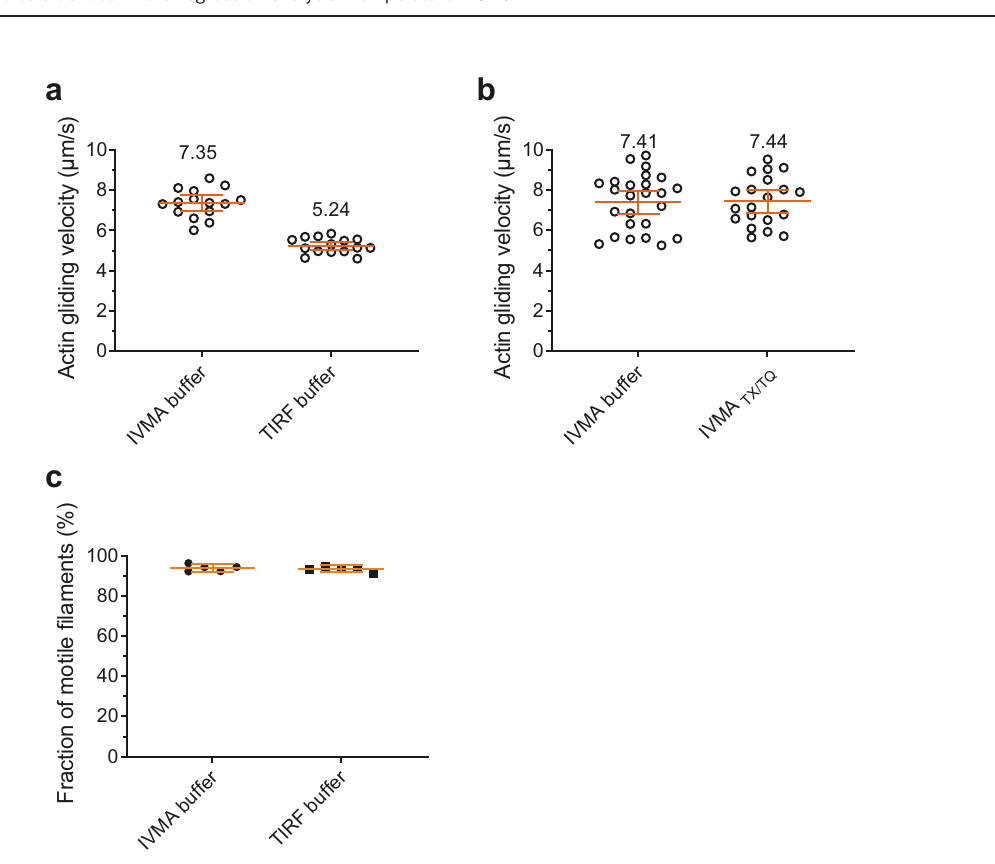
Fig. 2 Single molecule ATPase. a Two principles for surface immobilization of myosin motor fragments . b Time-averaged Alexa-ATP fl uorescence projections of 15 min videos (50 ms exposure time/frame). (i) Simple HMM deposition at 34.3 pM (left) and 343 pM (right). (ii) Optimized HMM deposition following high [ATP] wash. Only spots de fi ned by previous position of F-actin fi lament were included in analysis. (iii) Image of optimized actomyosin deposition followed by low [ATP] wash showing co-localization of Alexa-ATP fl uorescence (gray spots) and F-actin fi laments (yellow). Only spots co-localizing with F-actin fi laments were included in analysis. Bars, 5 µ m. c Representative time traces of (i) single-molecule Alexa-Ph bleaching, (ii) HMM basal ATPase, and iii, actin-activated HMM ATPase. Bleaching was observed either using standard in vitro motility assay (IVMA) buffer or optimized TIRF microscopy buffer (TIRFM) as described in the text (for details see Supplementary Information sections 1.2 and 1.9), whereas ATPase traces were from experiments using TIRFM buffer. d Cumulative frequency distributions of single-molecule Alexa-Ph until bleach or fi rst blinking event. The distributions are fi tted by single exponential functions (solid lines). e Cumulative frequency distribution of Alexa-nucleotide dwell time events on HMM surface hotspots (IVMA buffer — simple deposition of HMM, TIRFM buffer-optimized deposition of HMM) were fi tted with double-exponential functions (solid lines). IVMA data from 118HMM molecules, N dwell = 2112, TIRFM data from 45 HMM molecules, N dwell = 785. f Amplitudes and rate constants from the fi tting of data in e . Note appreciably lower rate constant values in TIRFM compared to IVMA buffer. g Cumulative frequency distributions of Alexa- nucleotide dwell time events comparing HMM basal (re-plotted from panel e ) and actin-activated ATPase activity. Actin-activated ATPase data were obtained from 37 actomyosin hotspots, N dwell = 879. The actin – myosin data were fi tted with triple exponential functions, whereas basal ATPase data were fi tted by double-exponential function as in f . h Rate constants obtained from fi ttings to data in f . i Amplitudes from fi tting the data in f . Error estimates refer to 95% con fi dence intervals derived in the regression analysis. Temperature: 23 °C.